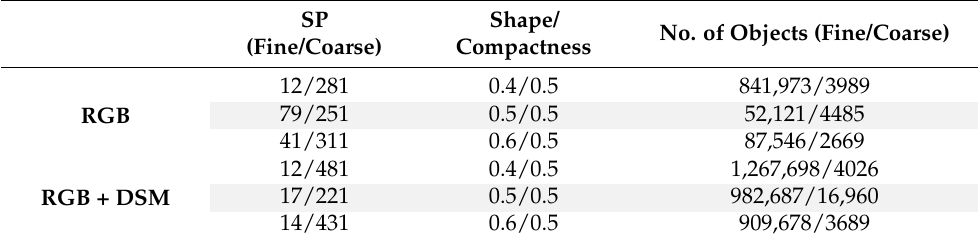
Table 2. Number of resulting segments using the ESP 2